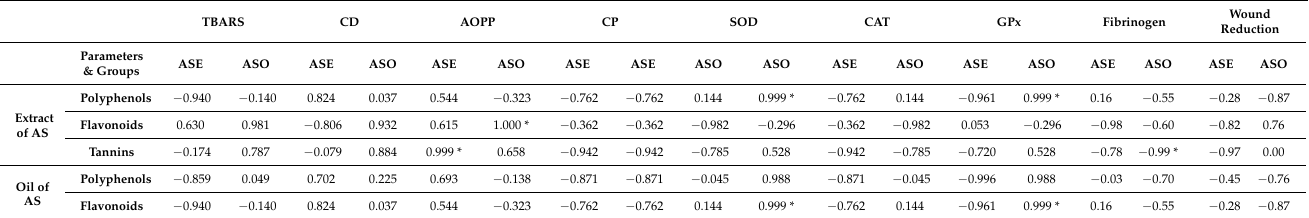
Table 4. Correlation matrix between phytochemicals, oxidative stress markers, fibrinogen and wound reduction. TBARS Parameters